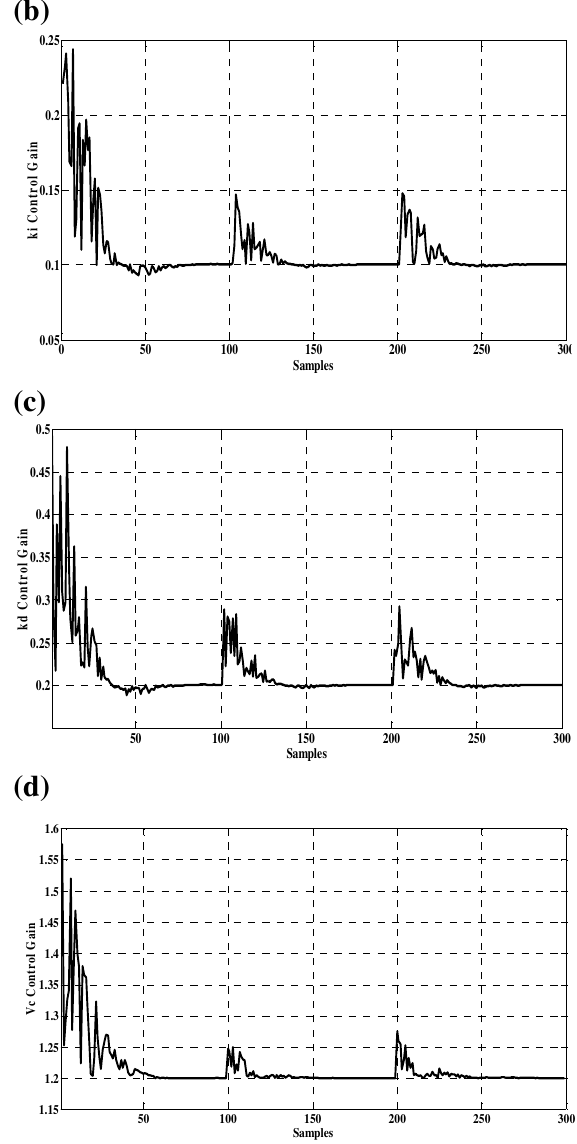
The small value of the error voltage signal between the reference voltage and the output voltage of the Buck converter system is shown in Figure (10-b). Figure (10-c) shows the response of the control action which has a fast and strong adaptability with robustness performance because the control parameters are learned and tuned by a powerful on-line Dolphin algorithm especially when adding boundary disturbance to show the control action has a capability to track the error voltage signal of the Buck converter system to follow the reference voltage as step change and reduce the effect of the load resistance